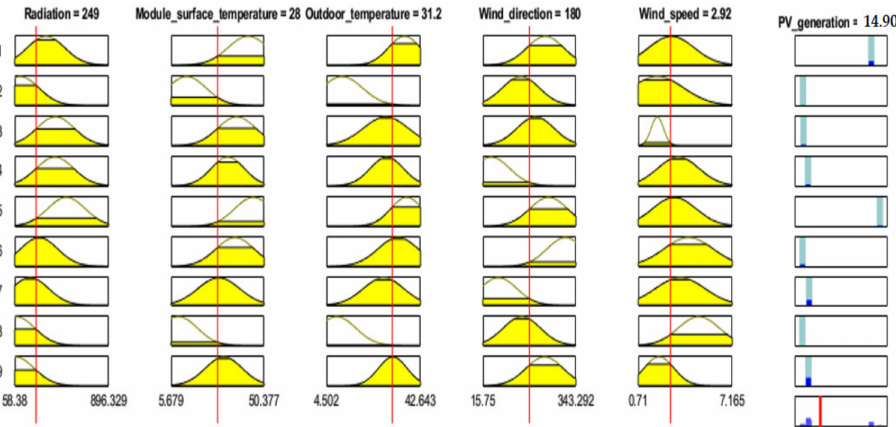
Figure 19. Fuzzy reasoning for PV energy generation